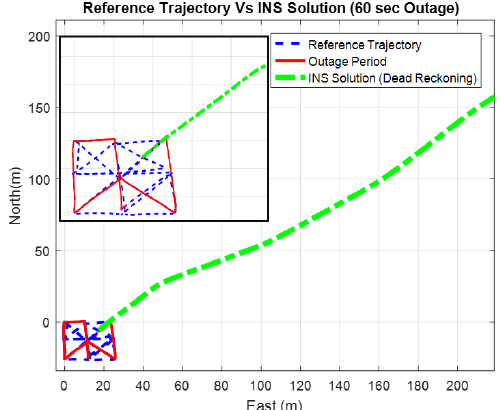
Figure 6. INS dead reckoning solution compared against reference trajectory for 60 secs of GNSS signals